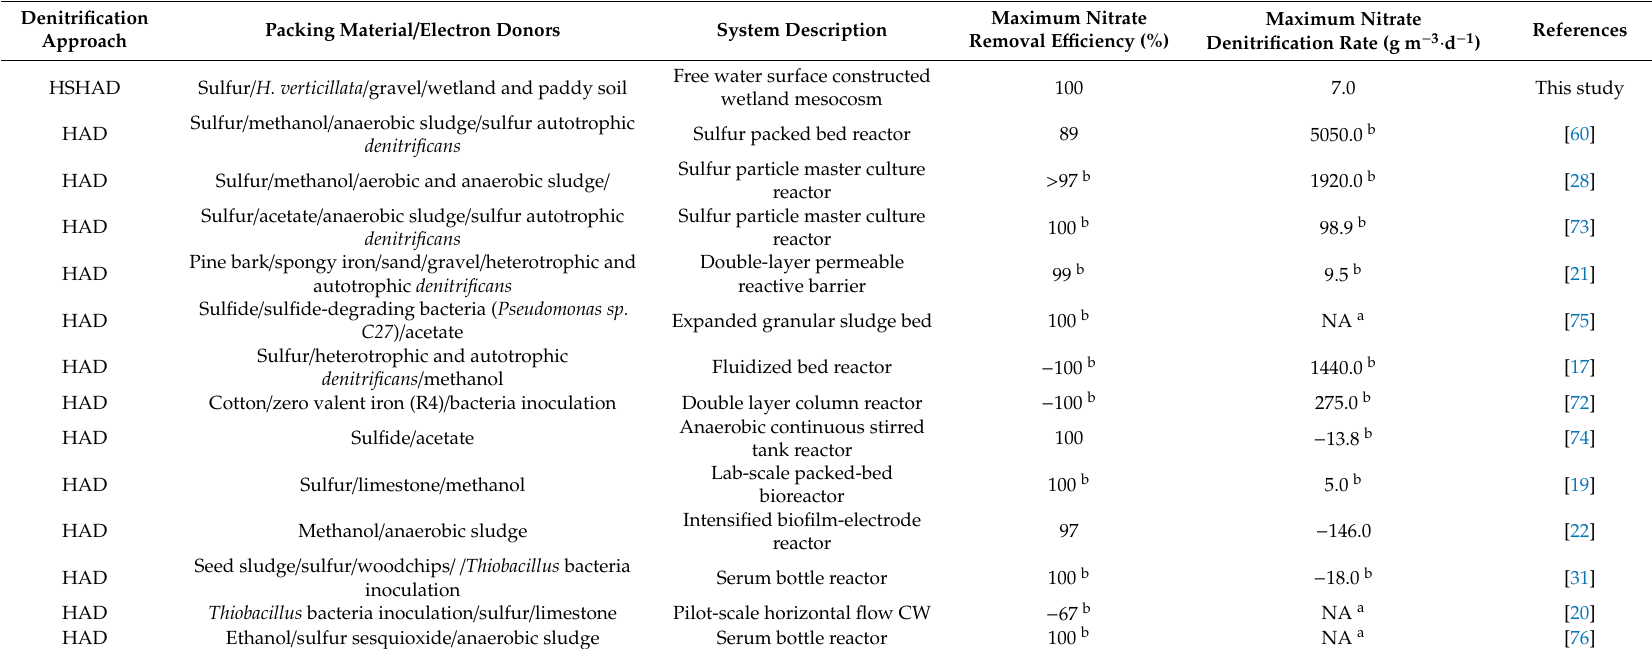
Table 4. Comparison of biological denitrification capacity among di ff erent